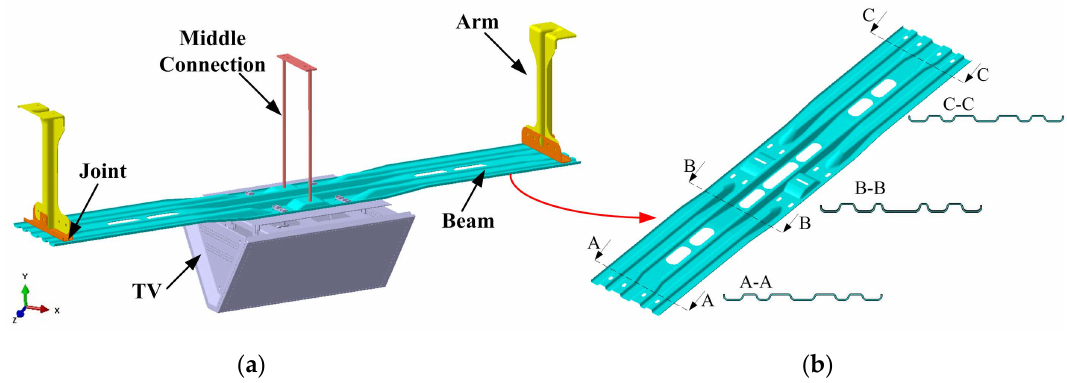
Figure 1. TV bracket model ( a ) and the typical section characteristics of the beam part ( b ).